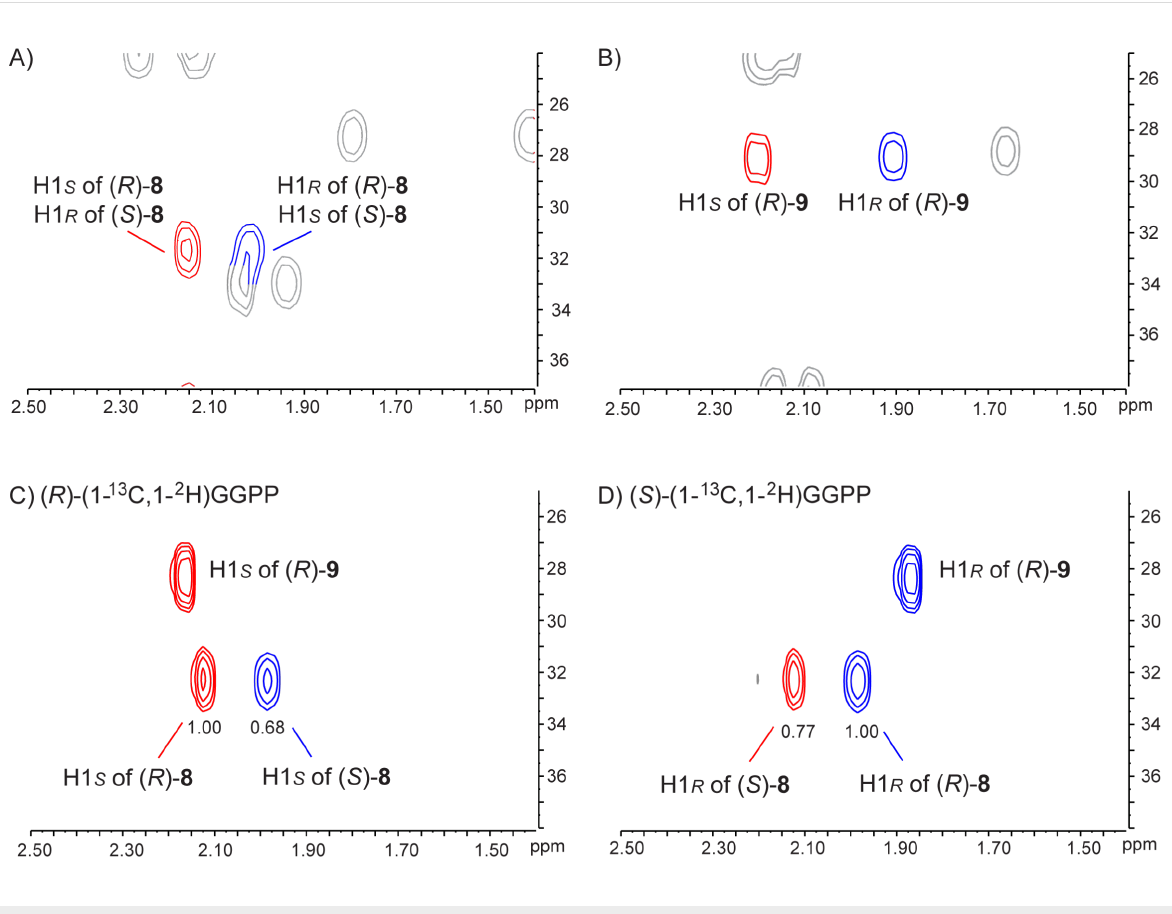
Figure 7: Determination of the absolute configuration of compounds 8 and 9 . Partial HSQC spectra of A) unlabelled 8 , B) unlabelled 9 , C) the mixture of labelled 8 and 9 obtained from ( R )-(1- 13 C,1- 2 H)GGPP, and D) the mixture of labelled 8 and 9 obtained from ( S )-(1- 13 C,1- 2 H)GGPP. The colour of cross peaks in blue and in red refers to the hydrogens in Scheme 1 of same